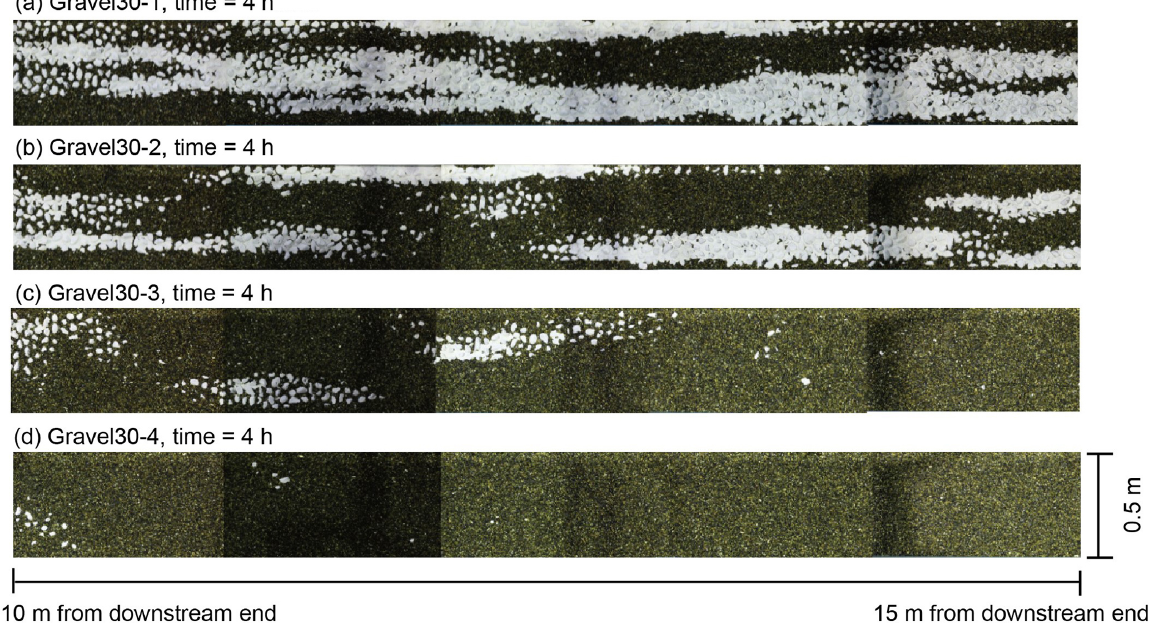
Figure 3. Bedrock exposure in Gravel30 series at the end of the experiment. The initial bed had 30mm embedded particles. The white bed represents exposed bedrock. The dark bed represents sediment covered bed.